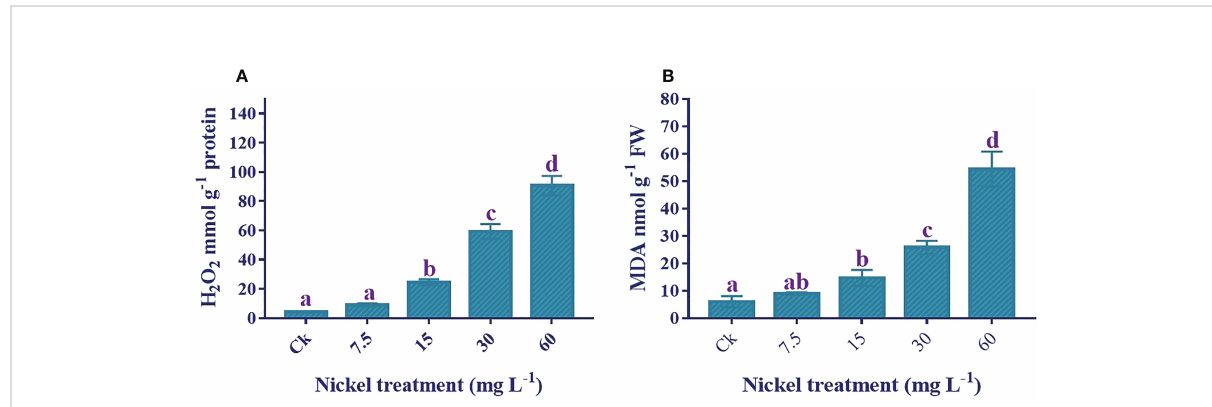
FIGURE 6 Effect of different Ni treatments on the H 2 O 2 and MDA in the leaves of sweetpotato. (A) H 2 O 2 content and (B) MDA content. According to the Duncan test, different letters indicate a signi fi cant difference (p < 0.05) among the fi ve treatments. The error bars represent the mean ±